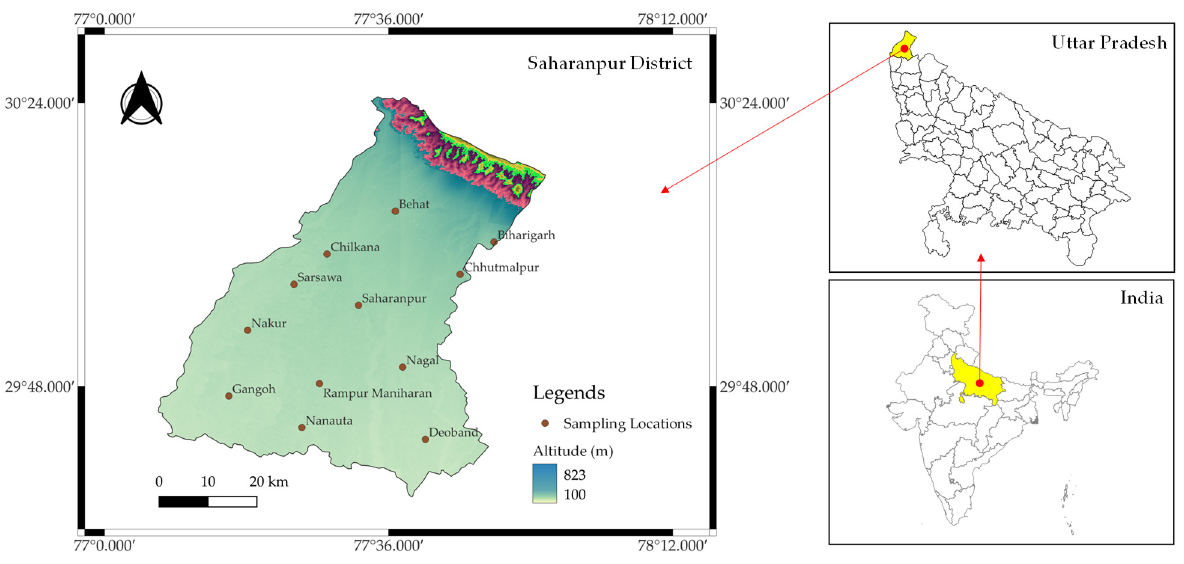
Figure 1. Map showing mango fruit ( M. indica ) sampling locations and digital elevation model (DEM) of Saharanpur district, Uttar Pradesh, India.